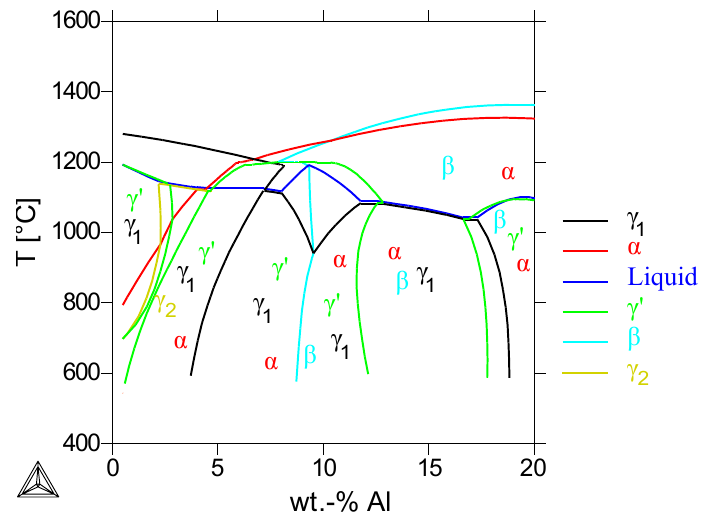
Pseudobinary phase diagram calculated by Thermo-Calc of the alloy Ni-30%Cu-22%Cr with variable Al-content. The stable phases are marked with their symbol, phase boundaries with the corresponding